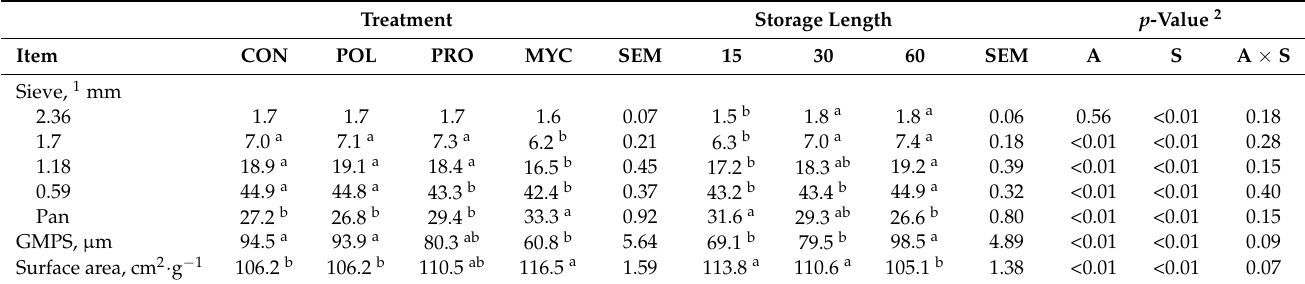
Table 3. Kernel fraction particle size distribution, geometric mean particle size (GMPS) and surface area of reconstituted corn grain ensiled for 15, 30 or 60 d, without additive treatment (CON), or treated with polysorbate 80 (POL), propionic acid (PRO) or polysorbate 80 and propionic acid (MYC). Treatment Storage Length p -Value 2